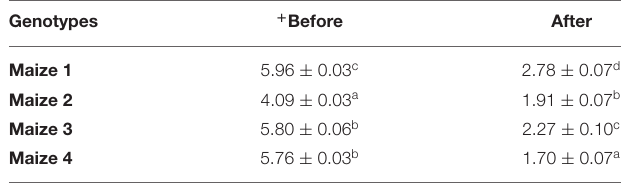
Values are mean ± SD of triplet determinations. + Values with different superscript along the column are significantly different from one another (p ≥ 0.05).